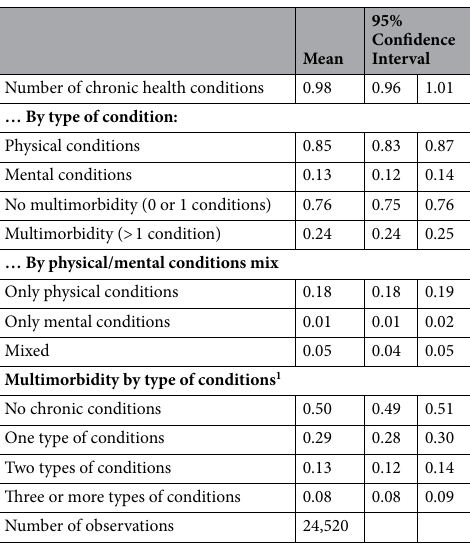
Table 2. Multimorbidity in England and Wales 2018/19. Population estimates for England and Wales. Standard errors adjusted for clustering and stratification. 1 The nine types of conditions are: respiratory, cancers, arthritis, obesity related, cardiovascular, other mental health conditions, psychiatric conditions, autoimmunity, and other chronic health condition. Source: Understanding Society (2020), Wave 10, linked with ONSPD (Nov 2020) and various indicators of neighbourhood disadvantage in 2019 at the 2011 LSOA level.